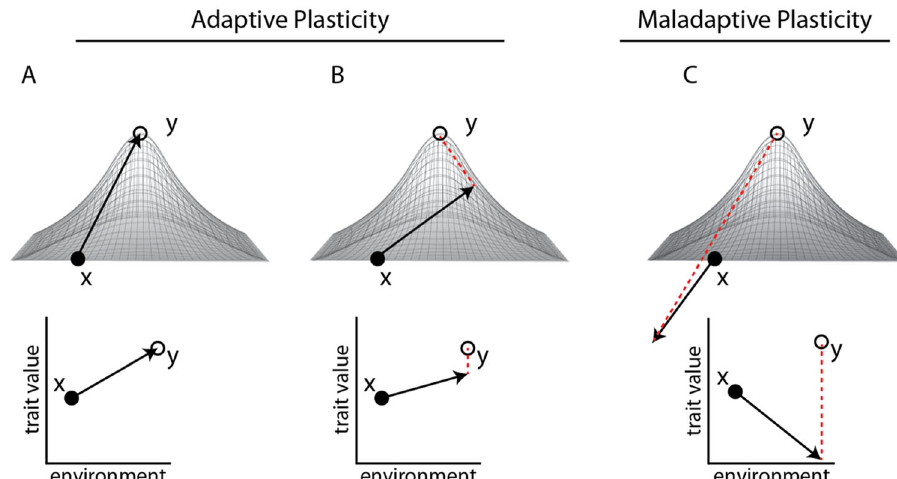
Fig. 1 Evolution of plasticity in novel environments. Phenotypic plasticity can in fl uence the evolutionary outcome for a population colonizing a novel environment. Ancestral plasticity may move the initial phenotype of a population ( x ) in any number of directions with respect to the local optimum of the novel environment (adaptive peak, y ). These variable responses are adaptive when they move phenotypic values directly into ( A ) or close to — but outside — the peak y . If suf fi cient genetic variation is exposed, natural selection can reinforce adaptive plasticity and move phenotypic means towards the new peak ( B ; dotted lines). However, natural selection is not expected when plasticity puts individuals directly onto the new peak ( A ). In the case of maladaptive plasticity ( C ), inappropriate responses to the novel environment move individuals away from the peak, reducing fi tness. Selection should reduce/reverse the reaction norm and restore the phenotypic mean back to the original ancestral value. In all cases, the strength of selection increases with distance from the peak (dotted lines in B , C ). Based on Fig. 2 in Ghalambor et al. 4